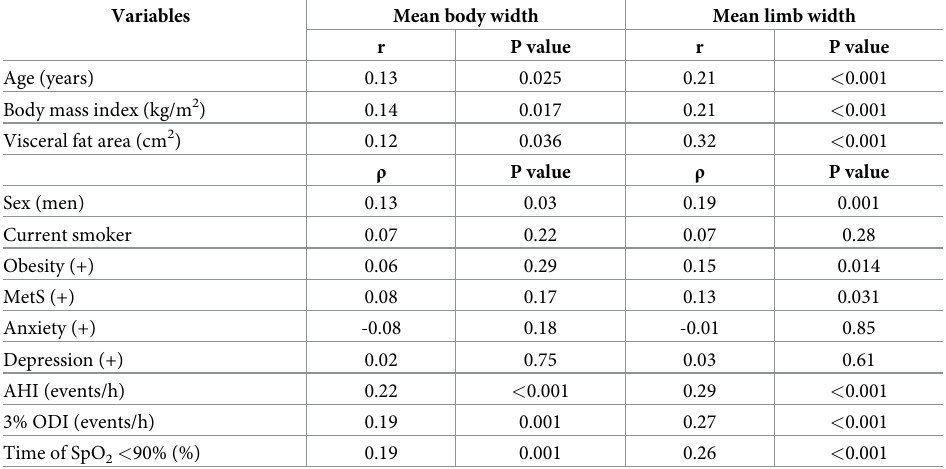
Correlations between adrenal measurements and variables are shown by Pearson correlation analysis (r)